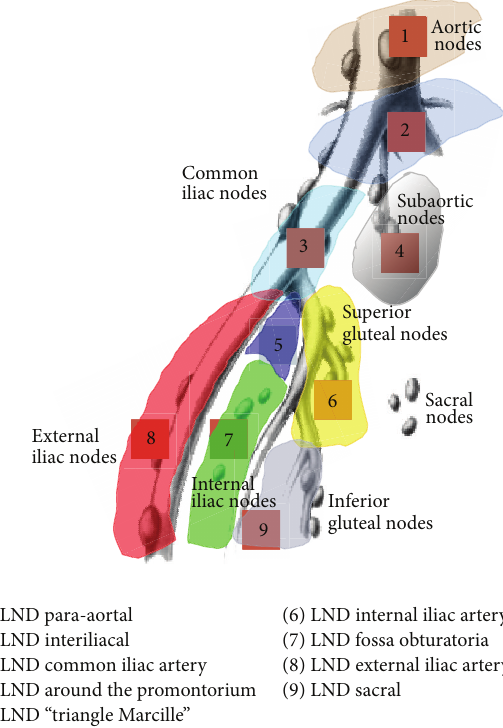
Figure 2: Location of LNs removed during SePLND.